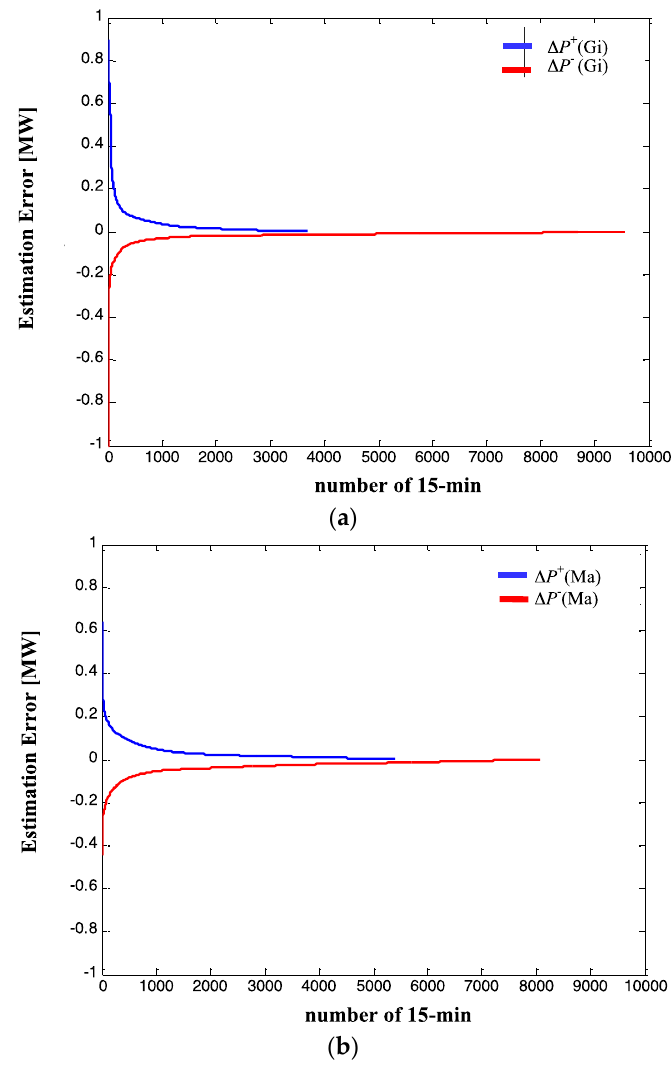
Figure 13. Duration curve of positive and negative estimation errors of the AC power profiles with respect to experimental results for the year 2012. ( a ) Site “Gi”; ( b ) Site “Ma”.